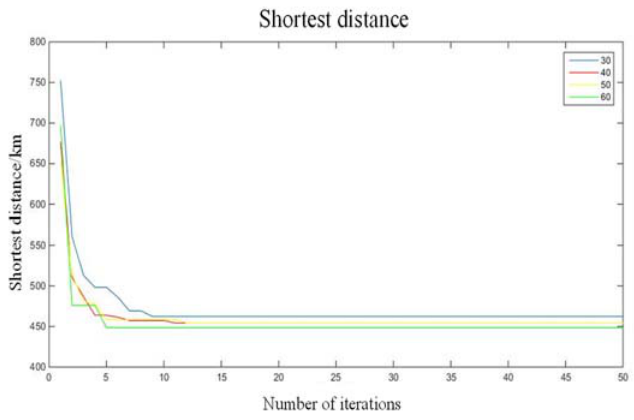
Figure 7. Comparison of the shortest distance.